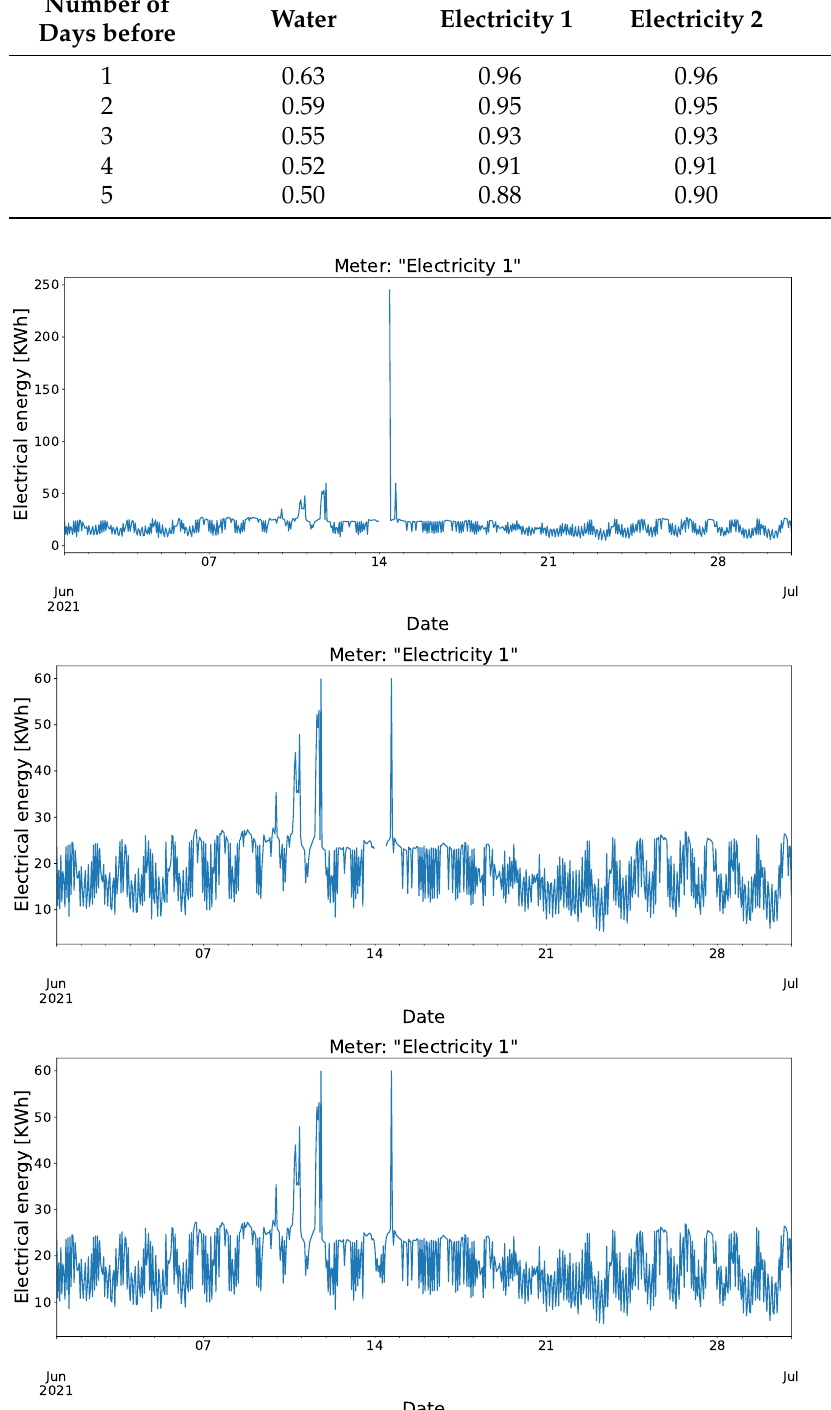
Figure 14. Pre-processing of the data collected by meter “Electricity 1”: original data ( top ), after re- moval of peaks ( middle ), and after the input of estimated values for the missing values ( bottom